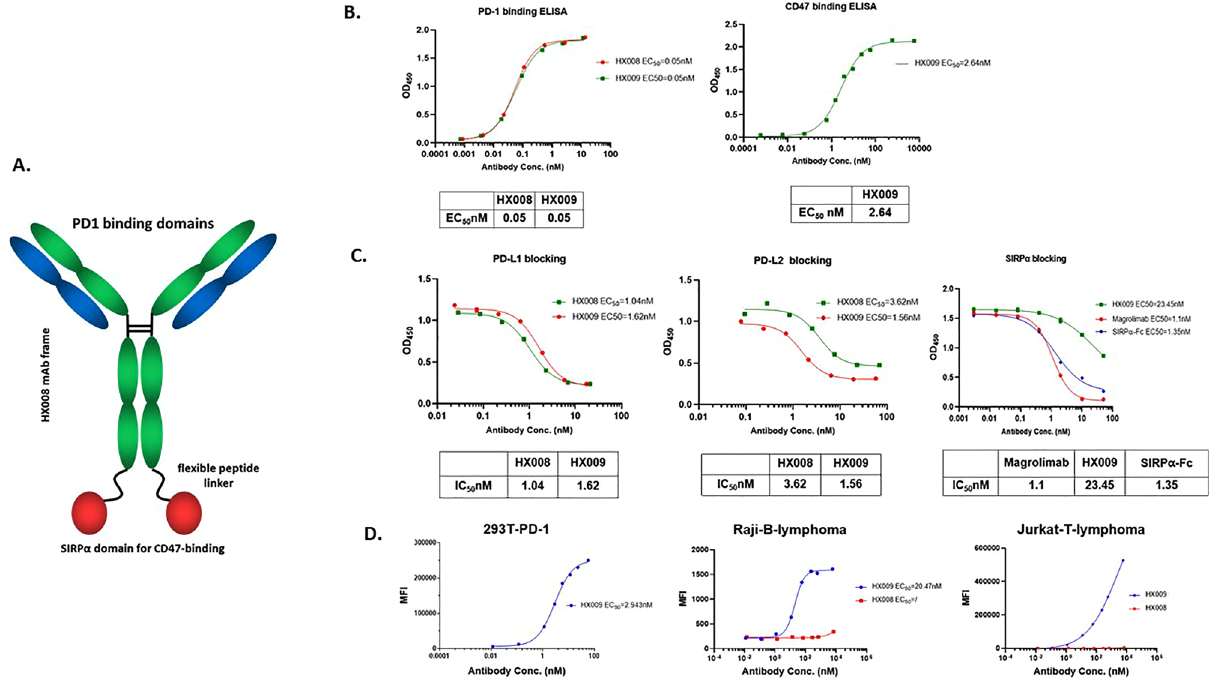
Figure 1. In vitro biochemical characterization of HX009. ( A ) Molecular structure of HX009: 2 × 2 symmetric BsAb molecule; ( B ) HX009 binding to PD1-his and CD47-his recombinant proteins as measured by ELISA assay; ( C ) HX009 competitively blocks PD1 and CD47 receptor binding to their respective recombinant ligand proteins, PD-L1-his, PD-L2-mFc and SIRPα-mFc; ( D ) HX009 binding to PD1-expressing 293 cell lines in vitro as measured by flow cytometry (Left panel), and to the CD47 + lymphoma cell lines (Raji B- and Jurkat T-lymphoma cells, presented by mean fluorescence intensity (MFI))(Middle and right panels). IC 50 (half maximal inhibition concentration) and binding EC 50 (half maximal effective concentration) were determined per four-parameter equation fitting